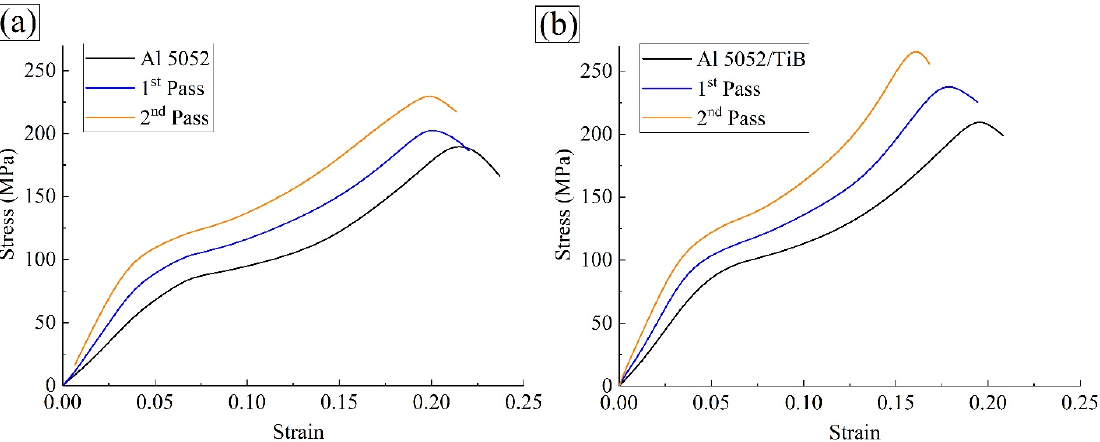
Figure 11. Stress–strain curve of ( a ) Al 5052 and ( b ) Al 5052/ TiB for one and two passes of FSP.